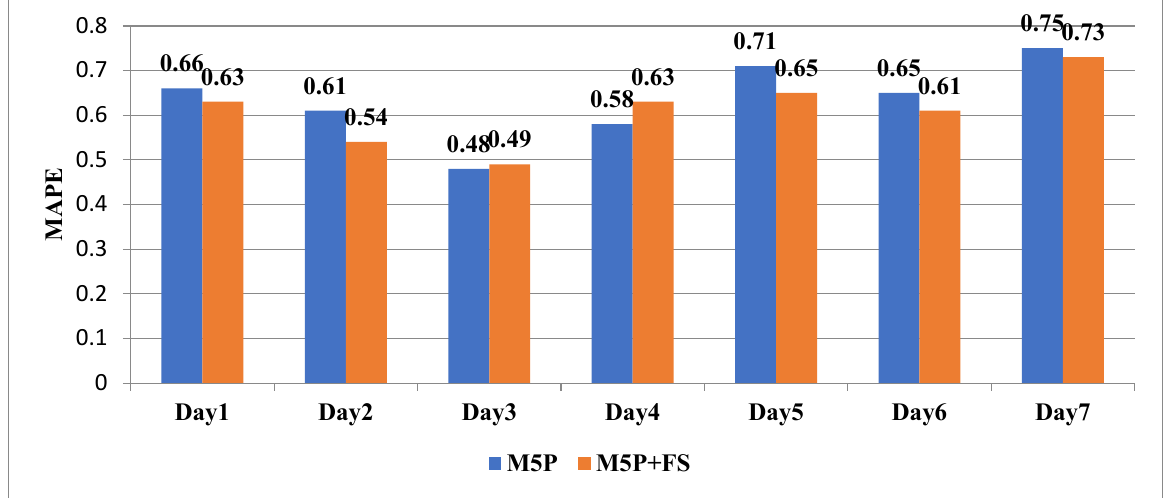
Figure 9. Representation of daily MAPE for summer season corresponding to M5P and M5P + FS.